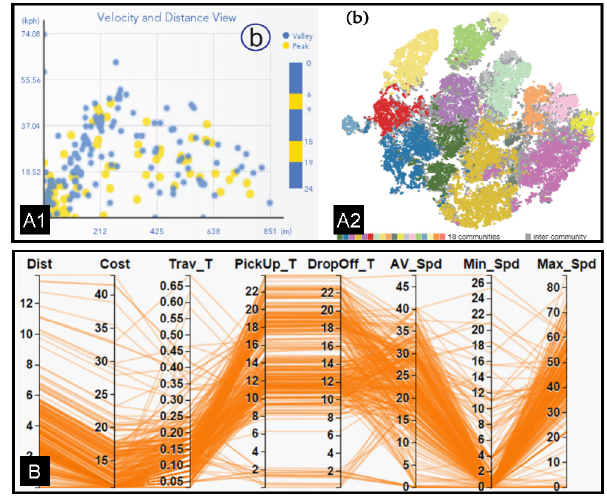
(A) Examples of scatterplots. (B) An example of PCP. Reproduced with permission from Ref. [56] for (A1), c (cid:13) IEEE 2014; Ref. [40] for (A2), c (cid:13) IEEE 2019; Ref. [47] for (B), c (cid:13) IEEE